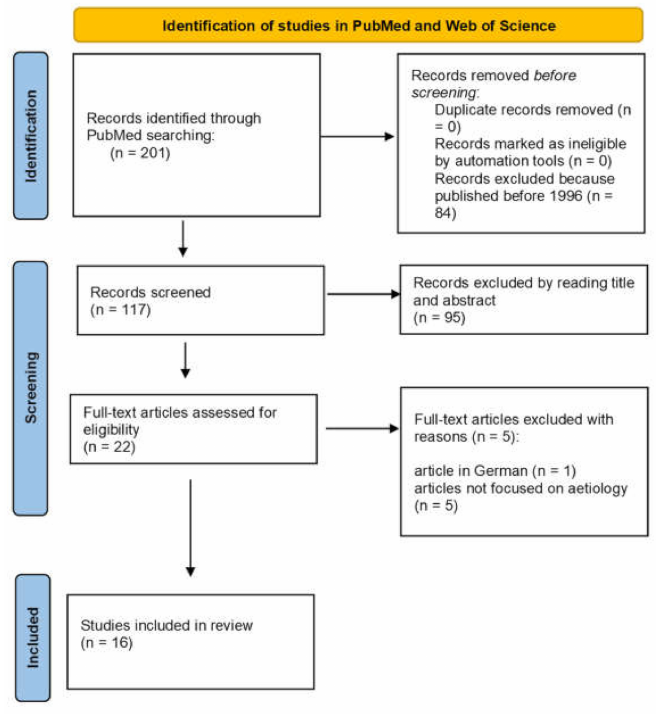
Figure 1. PRISMA